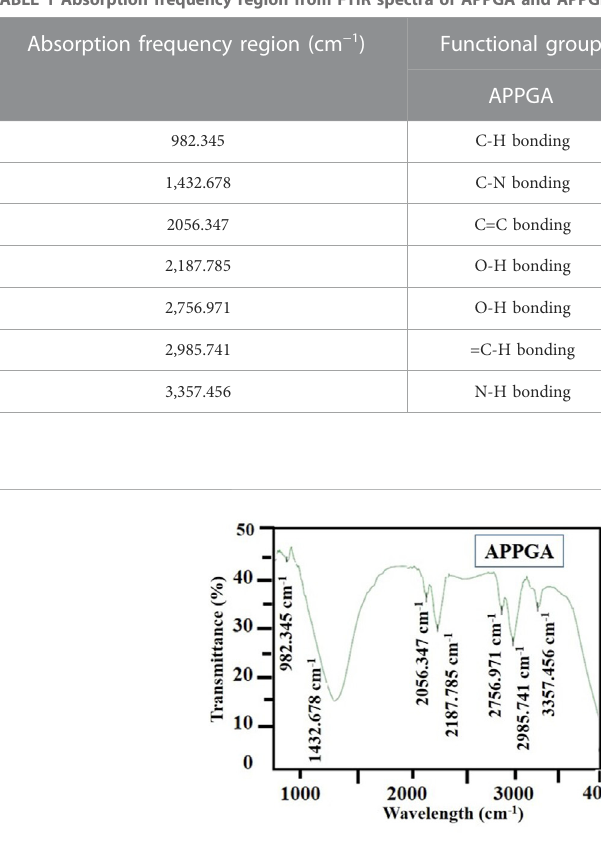
TABLE 1 Absorption frequency region from FTIR spectra of APPGA and APPGE.